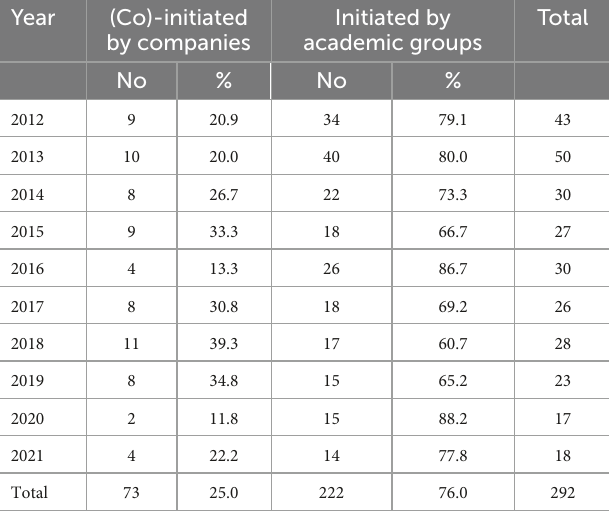
TABLE 2 Annual number of initiated geriatric drug trials on solid tumor by sponsor type, 2012–2021.